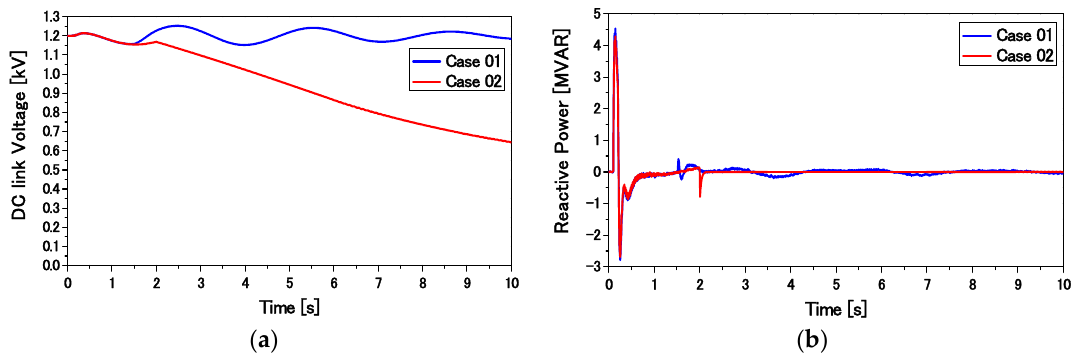
Figure 28. Individual responses of the DFIG: ( a ) DC ‐ link voltage; ( b ) reactive power output of GSC.